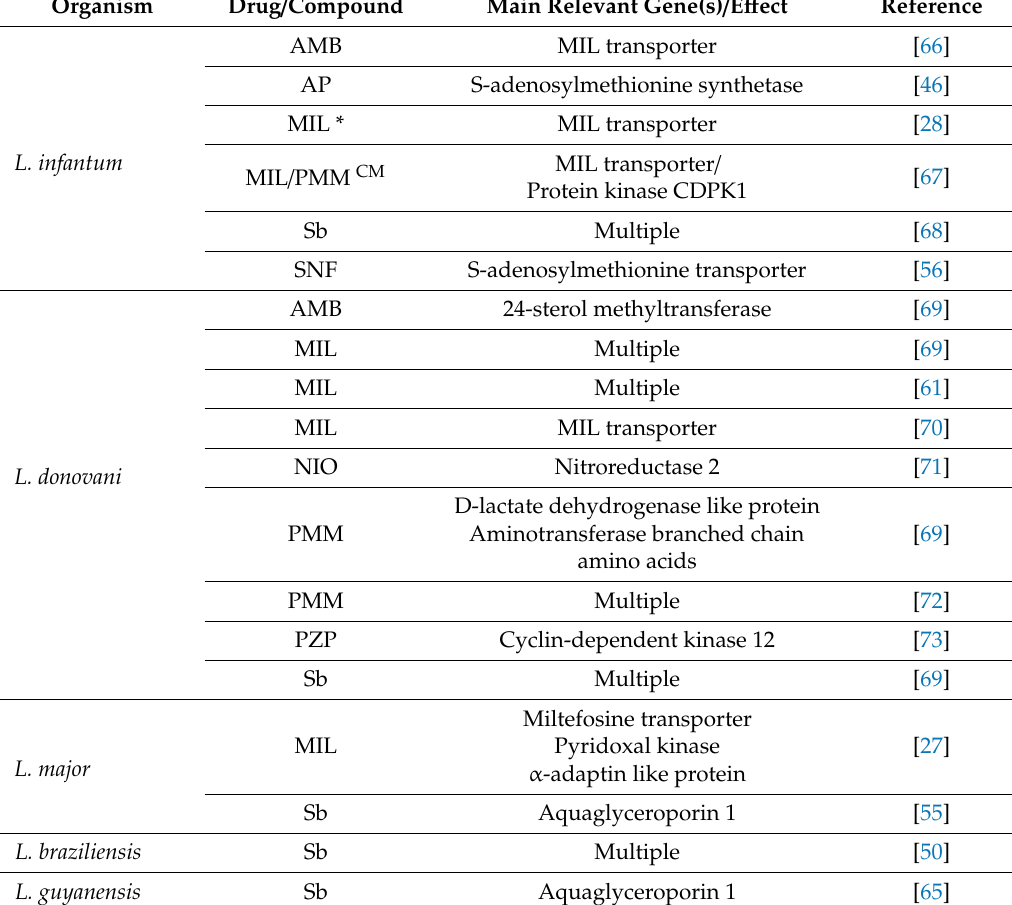
Table 1. Comparative whole genome sequencing (WGS) studies on laboratory-induced resistant strains to unravel the MoA or MoR of anti-kinetoplastid drugs. Experiments with Leishmania spp. and T. cruzi were performed on promastigotes and epimastigotes,